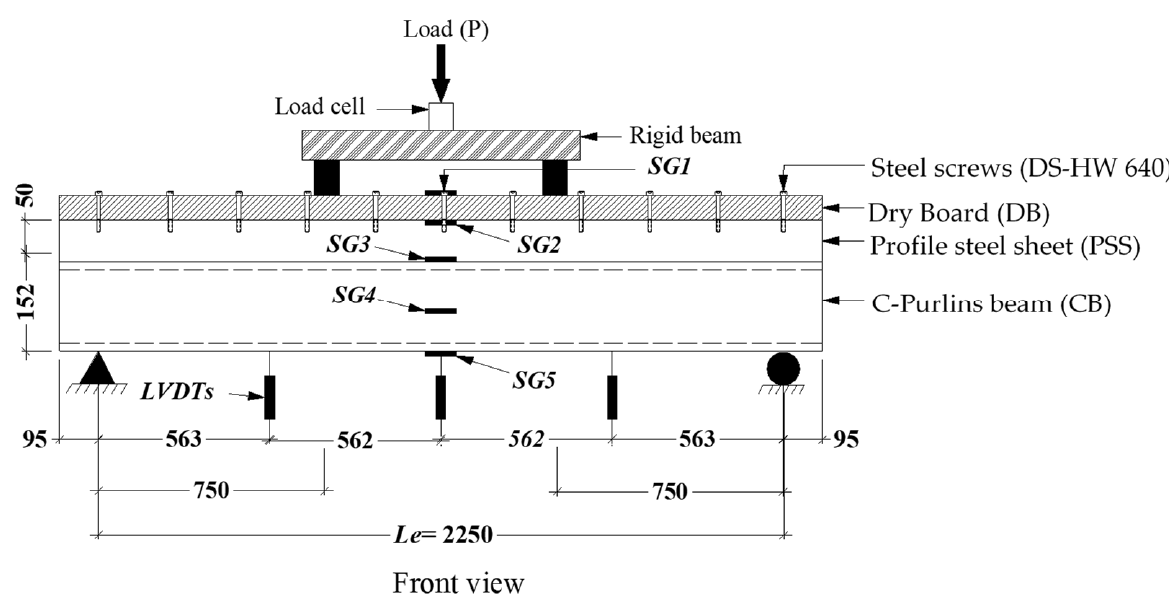
Figure 7. Typical test setup (all units in mm).